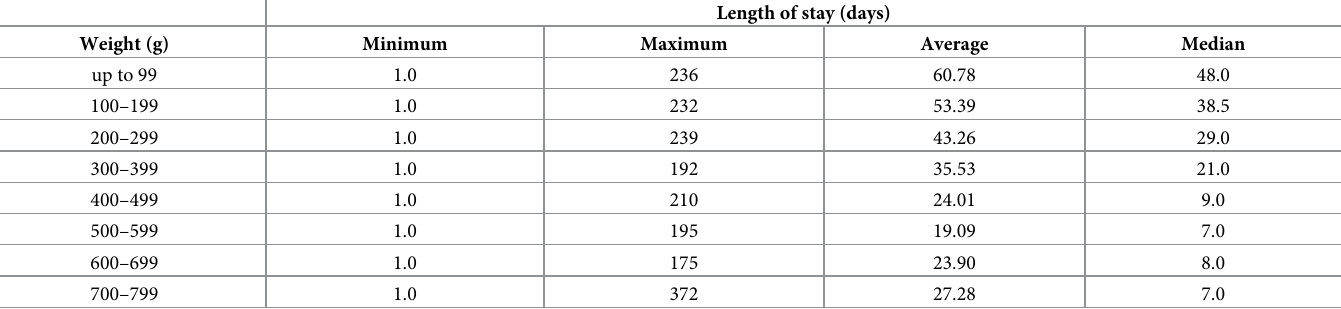
Table 3. Minimum, maximum, median and average length of stay (days) of juvenile European hedgehogs released from rescue centers in the period from 2010 to 2019. Weight (g)